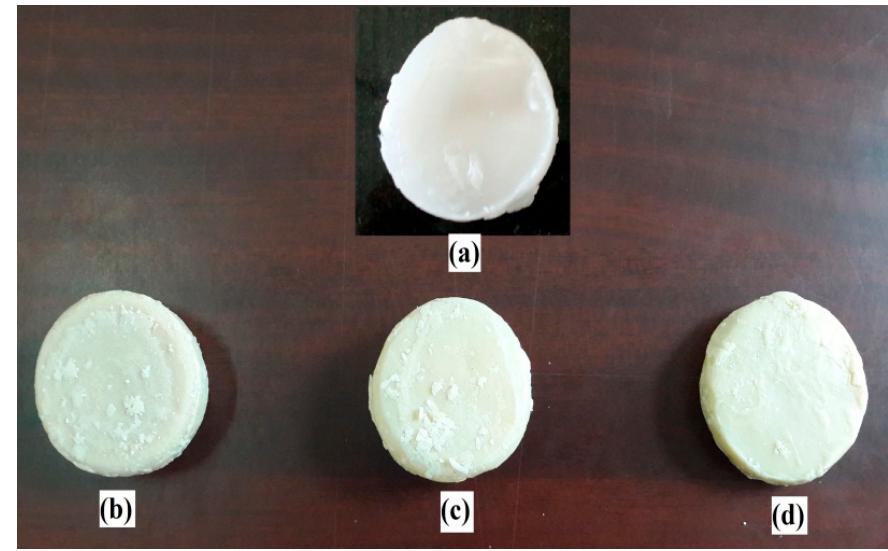
Figure 1. Molded hybrid-nano / para ffi n samples. ( a ) Pure para ffi n; ( b ) 0.5 HnP; ( c ) 1.0 HnP; ( d ) 2.0 HnP.